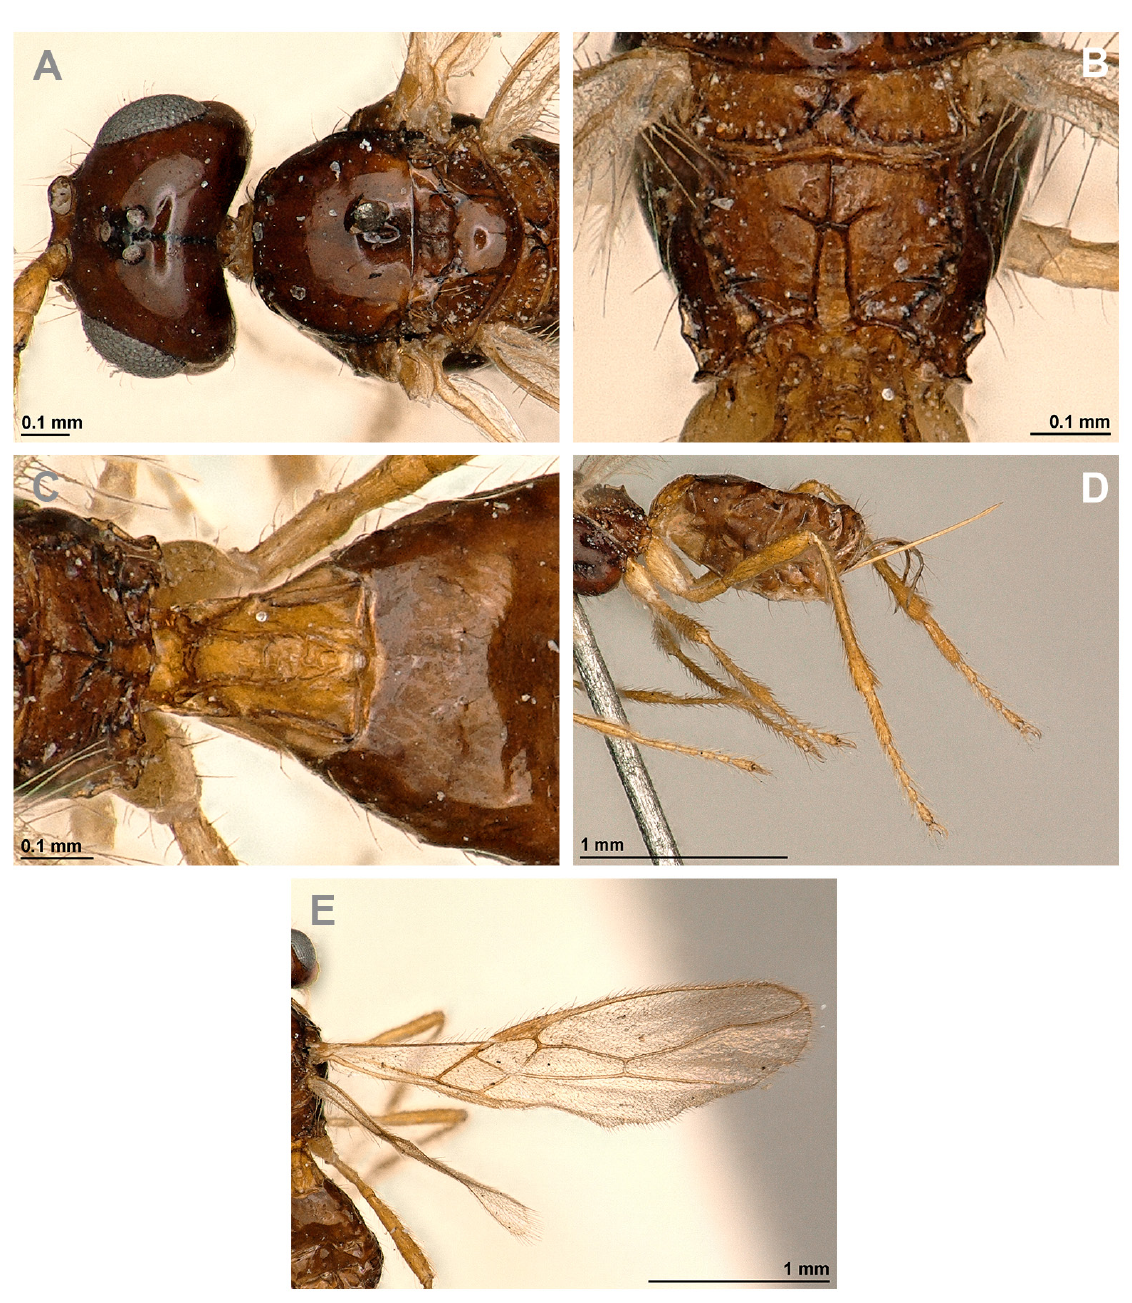
Fig. 49. Asobara pulchricornis (Szépligeti, 1911), ♀, holotype (NHMB). A . Head and mesoscutum, dorsal view. B . Propodeum, dorsal view. C . First metasomal tergite, dorsal view. D . Hind leg, metasoma and ovipositor, lateral view. E . Fore and hind